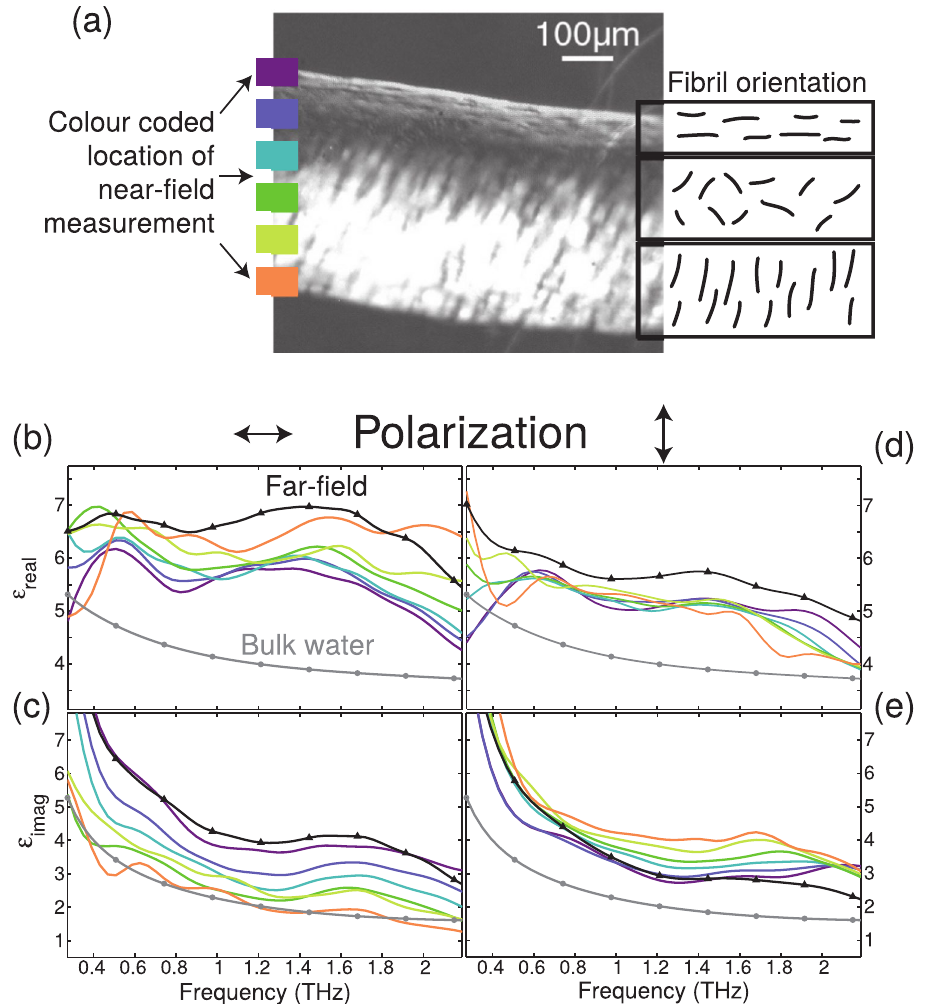
Figure 3. ( a ) Photomicrograph and schematic diagram of a cross-section of bovine articular cartilage taken with polarization microscope (Nikon Elclipse E200) at 45° to the articular surface. Boxes of different colour indicate locations from which THz measurements were taken. ( b – e ) Real and imaginary part, respectively, of the sample’s dielectric function for horizontally (vertically) polarized incident THz beam. Bulk water data from fit parameters of ref. 22 . Note the colour coding of the lines correlates with in part ( a ), indicating the location on the sample from where THz measurements were performed. The raw THz data as well as absorption maps at 1 THz can be seen in the supplementary information section